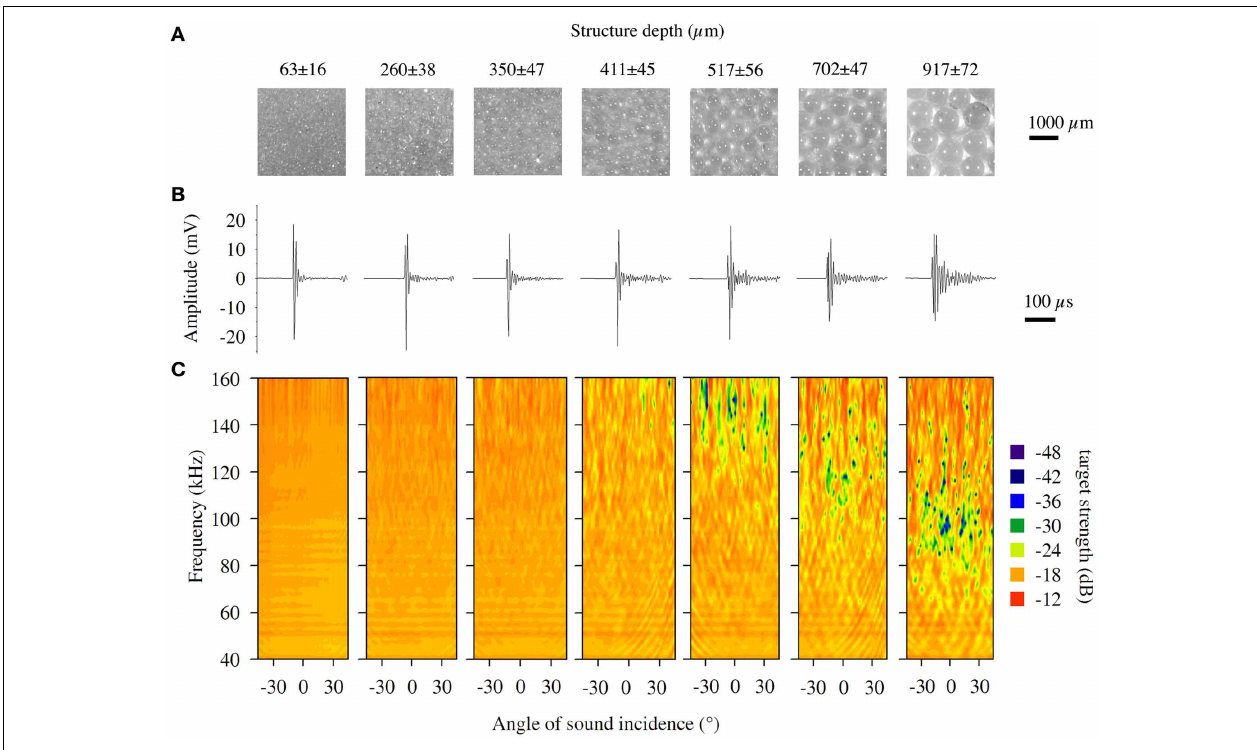
FIGURE 3 | Magnified images, impulse responses and spectral directional plots for structured targets. (A) Magnified images (six times) of the structured targets, which were spheres coated with fine glass beads. (B) Representative impulse responses and (C) spectral directional plots of the structured targets.